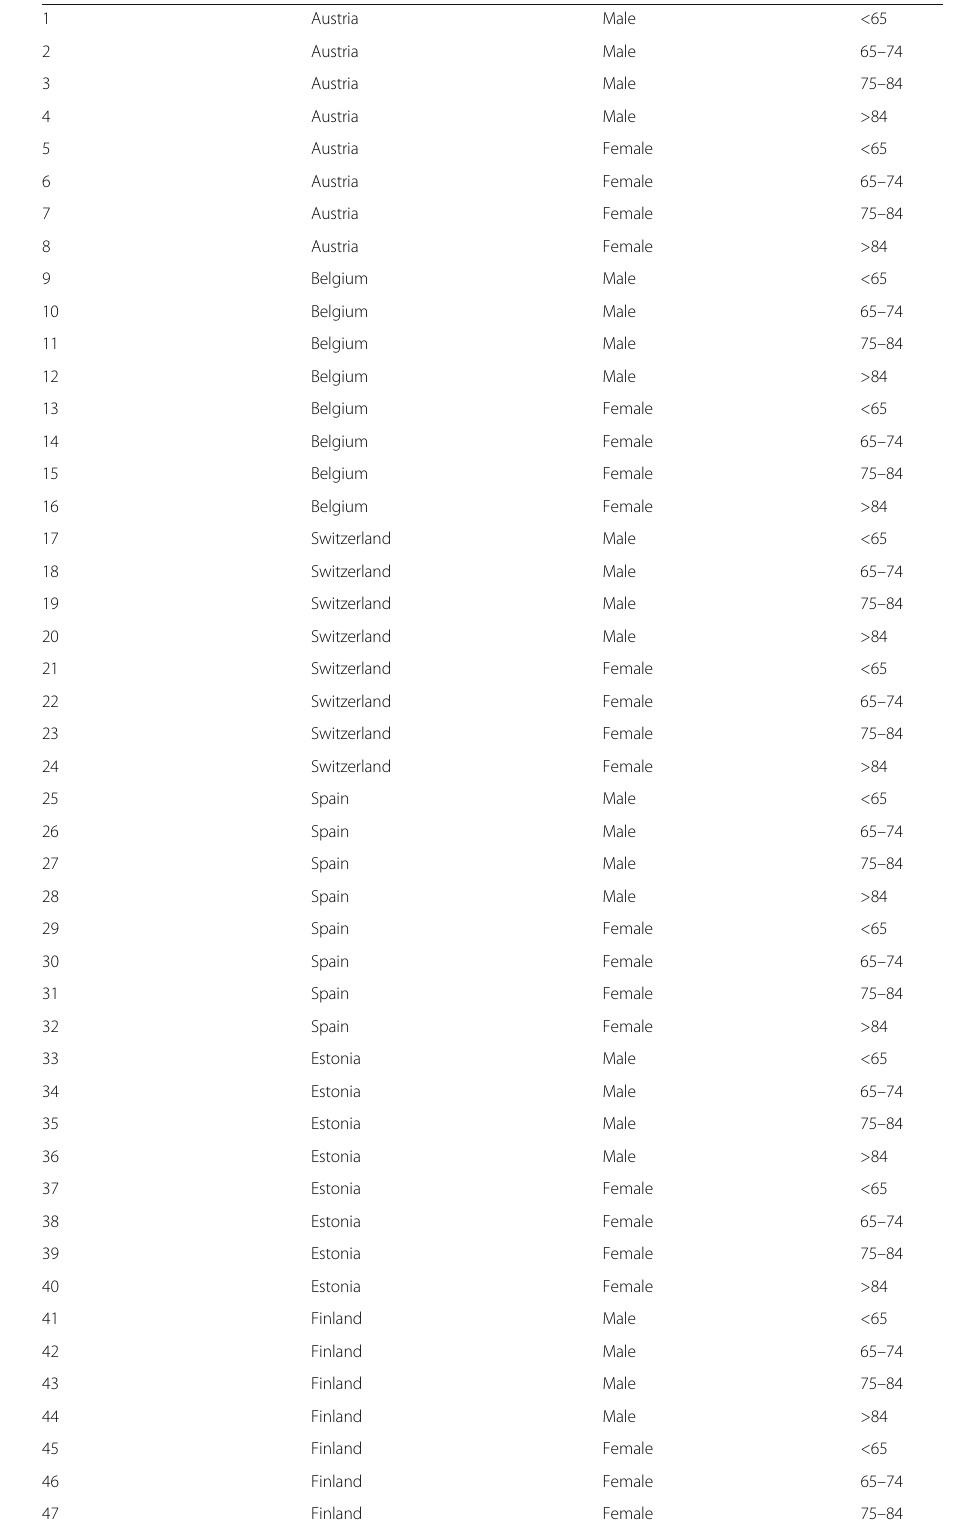
Table 3 Order of time series used in the